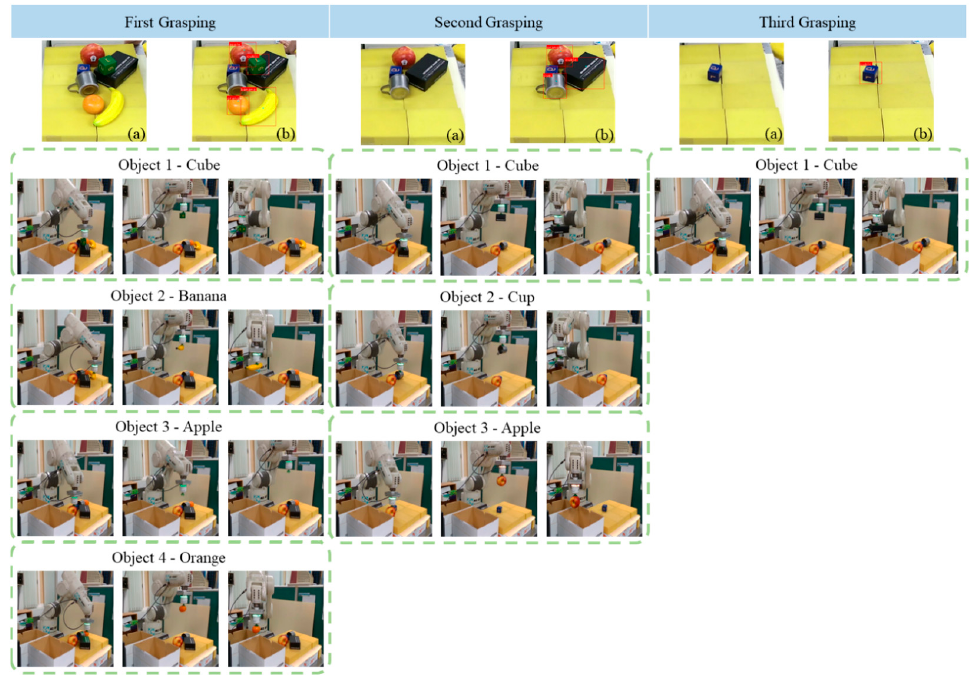
Figure 18. Image sequence of object grasping/classification experiment ( a ) original image ( b ) classification results of YOLOv3.